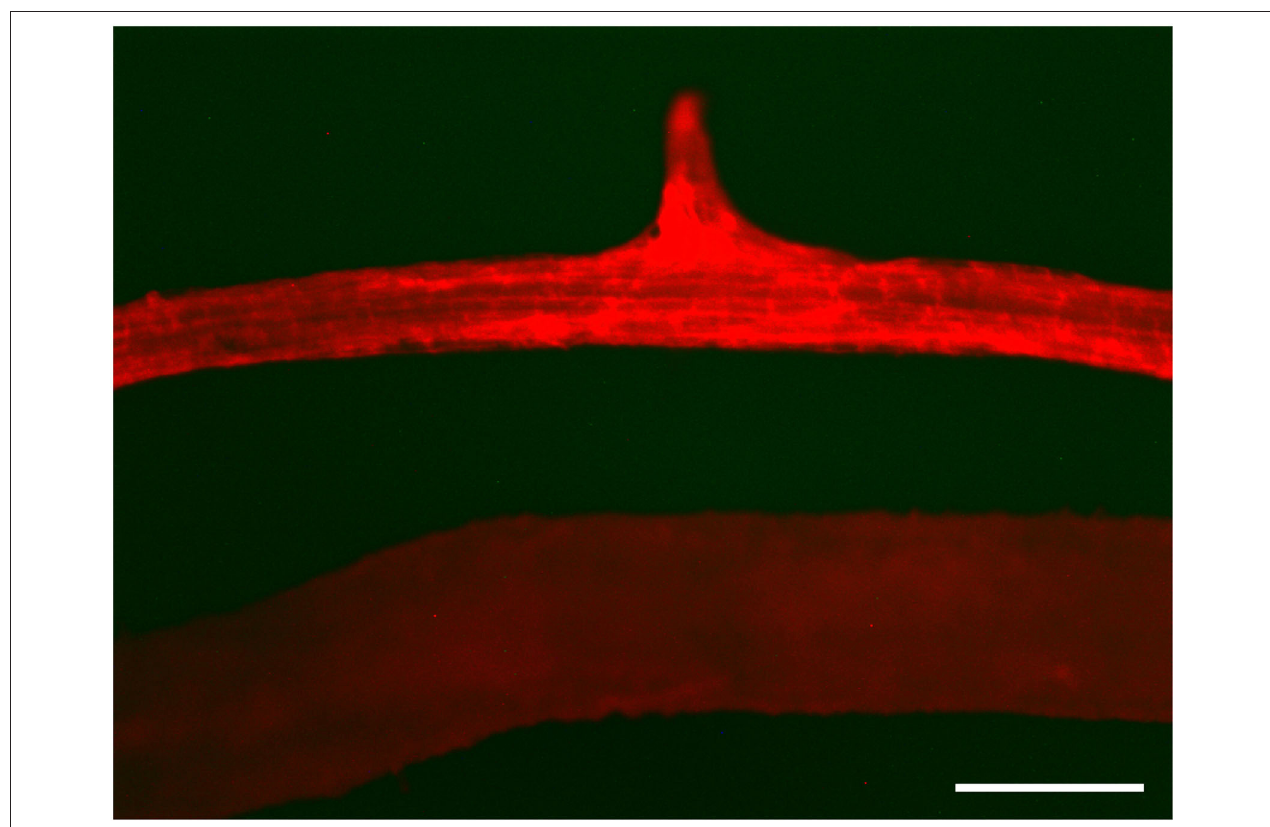
FIGURE 9 | Cre/lox and FLP/FRT-mediated site-specific recombination. Red fluorescence was detected in the recombination of 1301-3-221-4-1 and 86-1-75-10-1 in which P35S in the pCre1301 transgenic plant was precisely inserted before DsRed and led to the expression of DsRed in engineered chromosomes by site-specific recombination in root tissue (upper) and the absence of red fluorescence protein in the 86-1-75-10-1 control (lower). DsRed fluorescence was observed by stereoscopic fluorescence microscopy. Bar = 500 µ